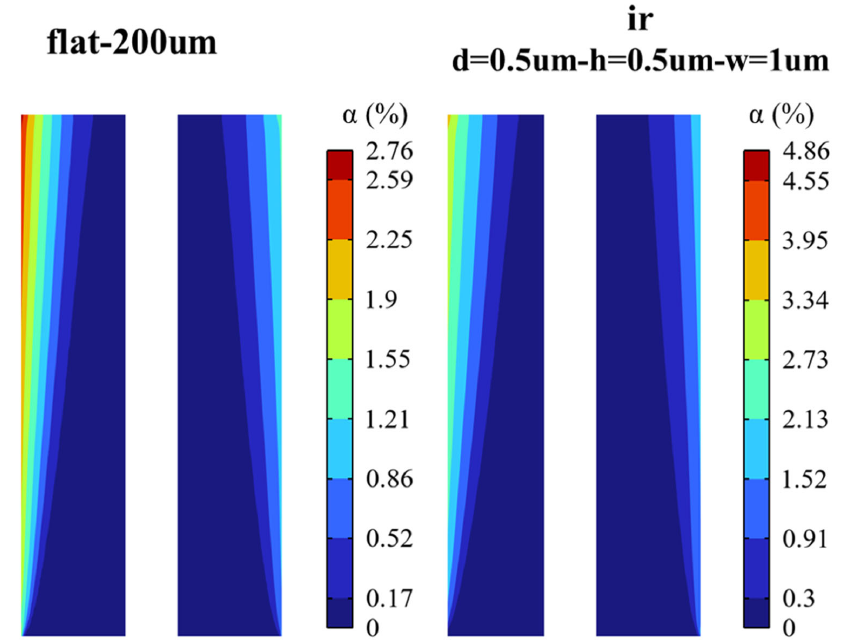
Figure 9. The gas void fraction distribution of micro-nano surface and vertical flat electrodes (U = 2 V). The gas void fraction curves of the micro-nano surface electrode and the vertical flat electrode at the top of the H 2 compartment under the same voltage are shown in Figure 10. The gas void fraction curves of the micro-nano surface electrode and the vertical flat electrode under the same voltage are shown in Figure 11. The void fraction of the micro- nano surface electrode in the x and y directions is more significant than that of the vertical flat electrode. Compared with the vertical flat electrode, the micro-nano surface electrode can produce more hydrogen and increase the void fraction due to the accumulation of bubbles, which leads to more turbulent diffusion and promotes the lateral penetration of bubbles. Furthermore, due to the limitation of H 2 compartment height, bubbles cannot continue to diffuse upward and then accumulate, which leads to a significant increase in void fraction near the top of the micro-nano surface electrode compared with the vertical flat electrode.